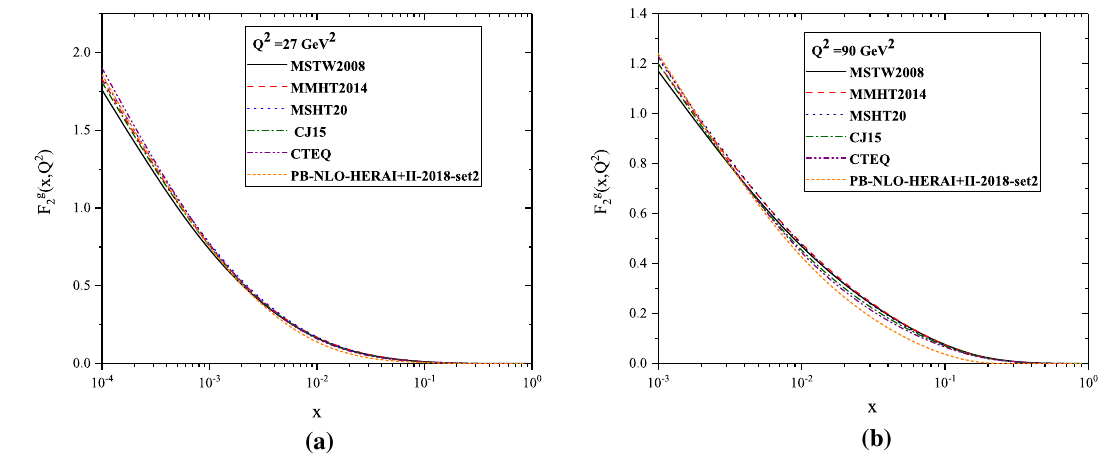
Fig. 9 The gluon contribution to structure function of proton for numerous sets of PDFs in the scale a Q 2 = 27 GeV 2 and b Q 2 = 90 GeV 2